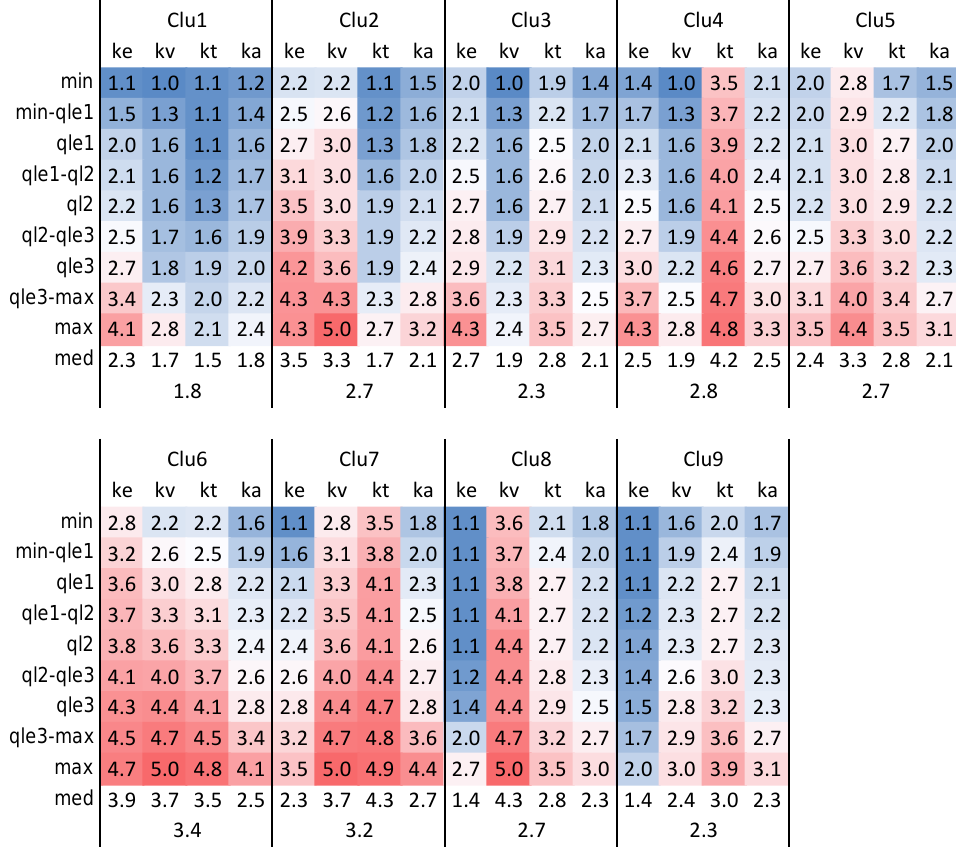
Figure 9. Comparison of the different clusters by minimum, average, maximum, and quartiles (normalised) scores of the main characteristics.